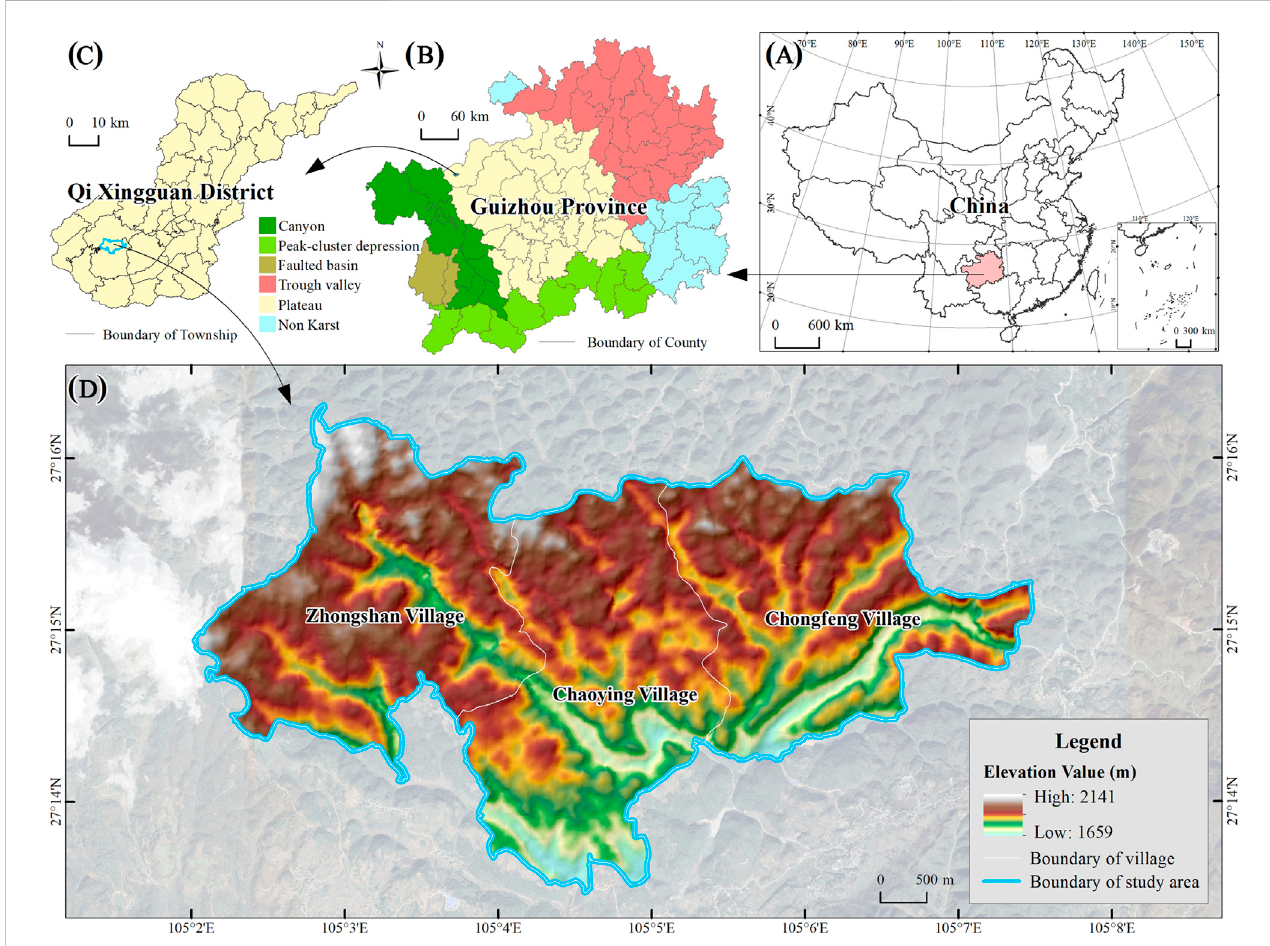
FIGURE 2 Geographical information map of the study area. In this map: (A) This panel is the location of Guizhou Province in China; (B) This panel is the karst landscape subdivision of Guizhou Province; (C) This panel is the location of study area; (D) This panel is the elevational distribution range of the study area.